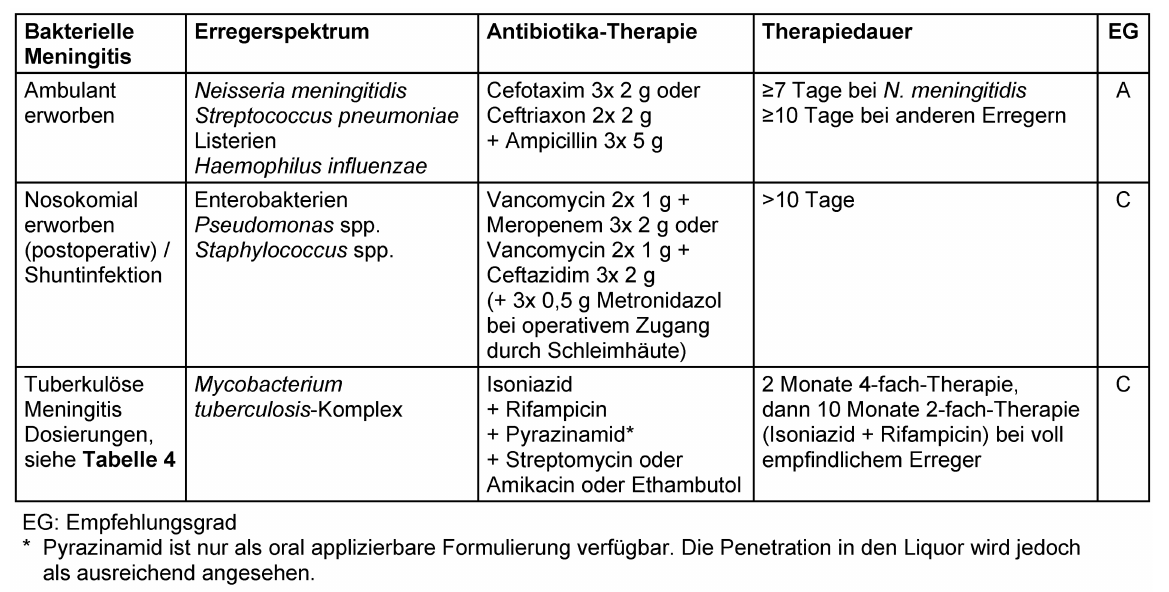
Tabelle 1: Kalkulierte Antibiotika-Therapie der bakteriellen Meningitis bei Erwachsenen.Die Empfehlungen der S2k-Leitlinie zur Therapie der Tuberkulose durch das Deutsche Zentralkomitee zur Bekämpfung der Tuberkulose e.V. im Auftrag der